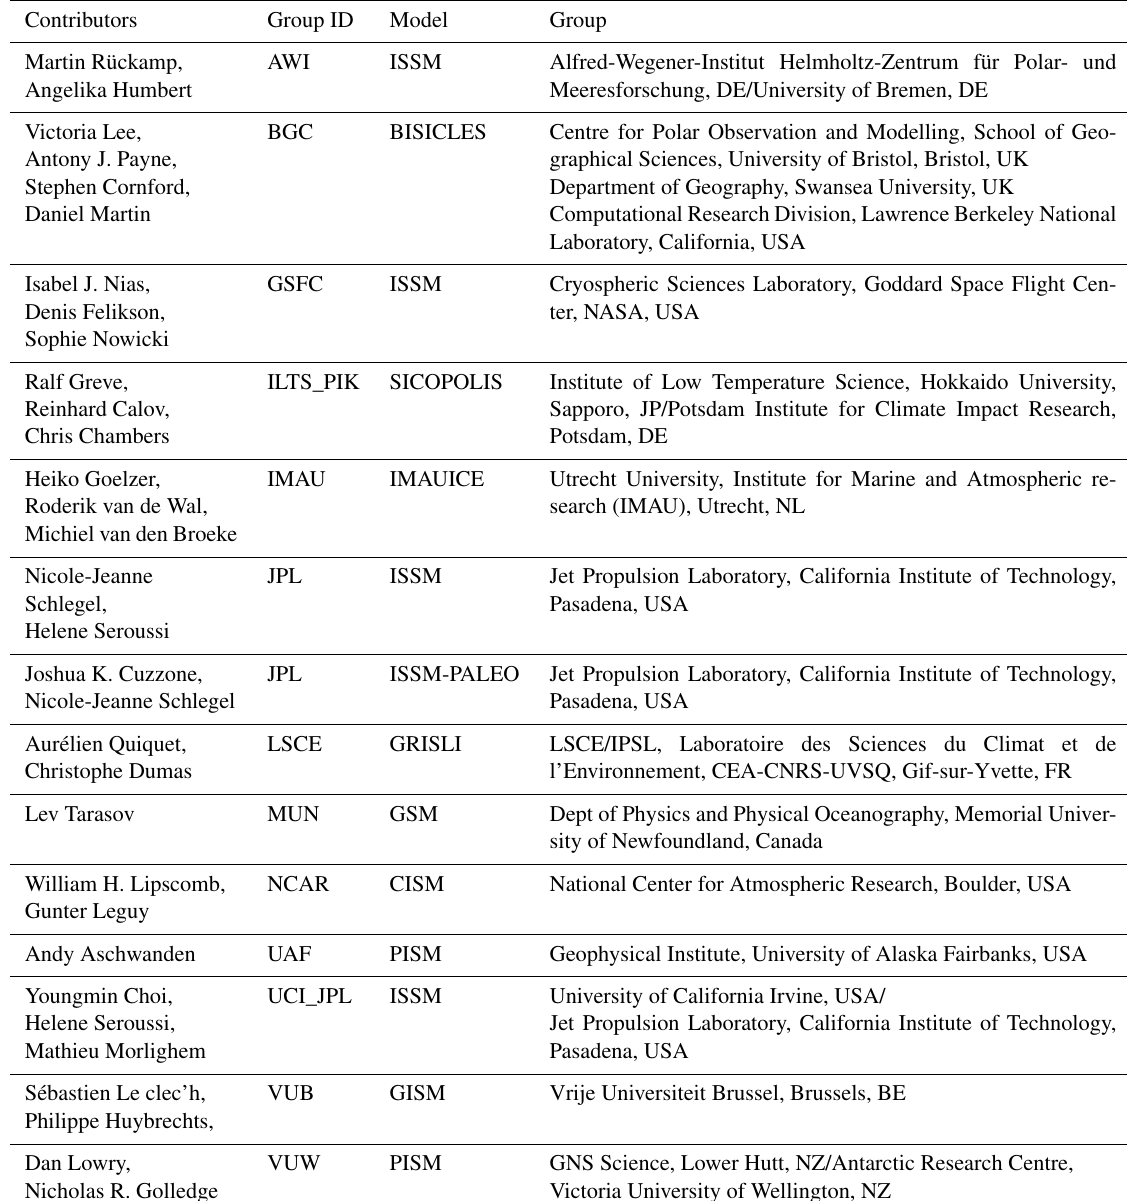
Table 2. Participants, modelling groups and ice sheet models in ISMIP6-Greenland projections.